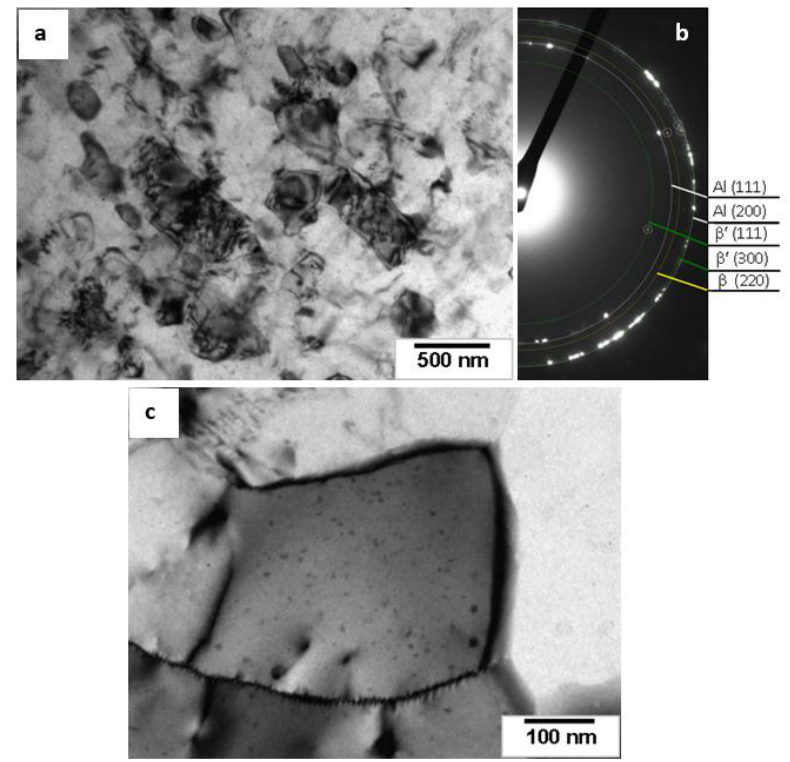
Figure 3. ( a ) Microstructure and ( b ) SAED patterns of the Al 6101 alloy after ECAP-C; and ( c ) view of strengthening second-phase precipitates formed in the matrix of the Al alloy after ECAP-C